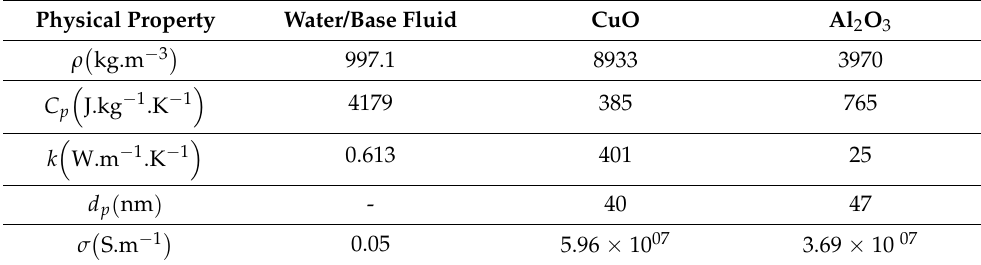
Table 2. Thermophysical properties of water and nanoparticles. Physical Property Water/Base